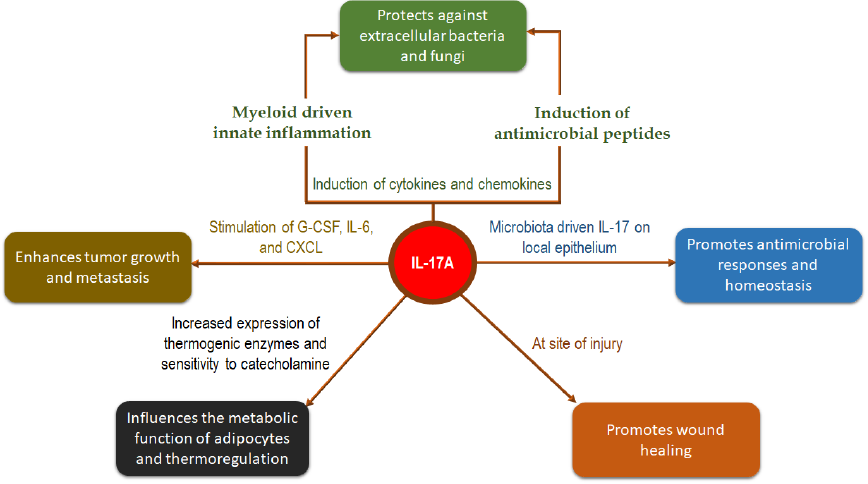
Figure 1. Physiological and immunological functions of IL-17A